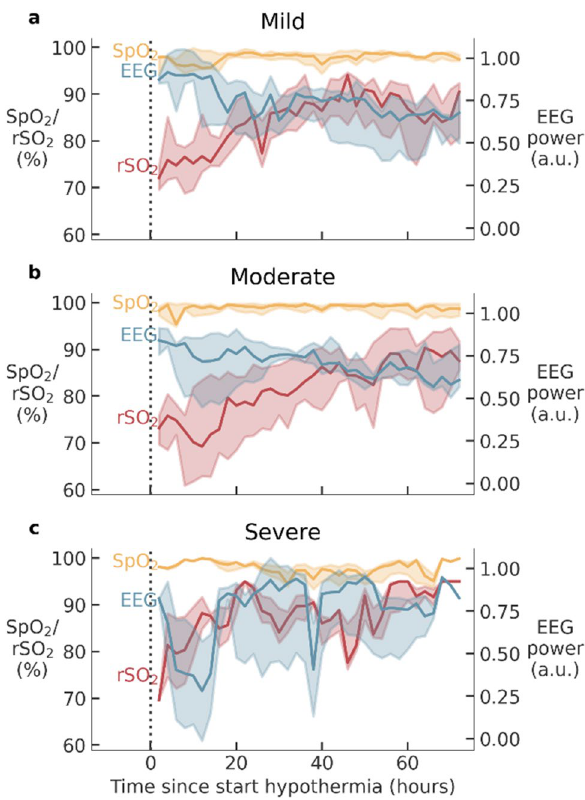
Figure 1. Hourly average values for EEG log bandpower, rSO2 and SpO2 per outcome group. ( a ) Mild outcome, ( b ) moderate outcome, ( c ) severe outcome. Solid lines represent the median and the shaded areas the inter-quartile range. The vertical dashed line represents the start of